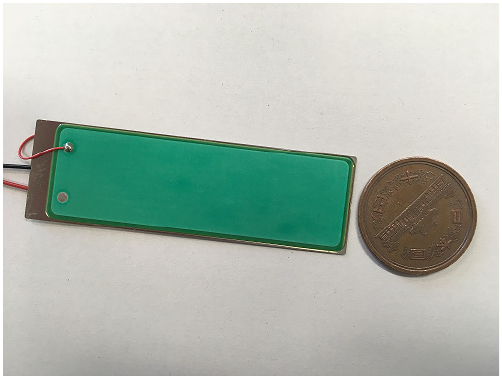
Figure 1. The bimorph type piezoelectric actuator PZBA-00030 by FDK used in this study.